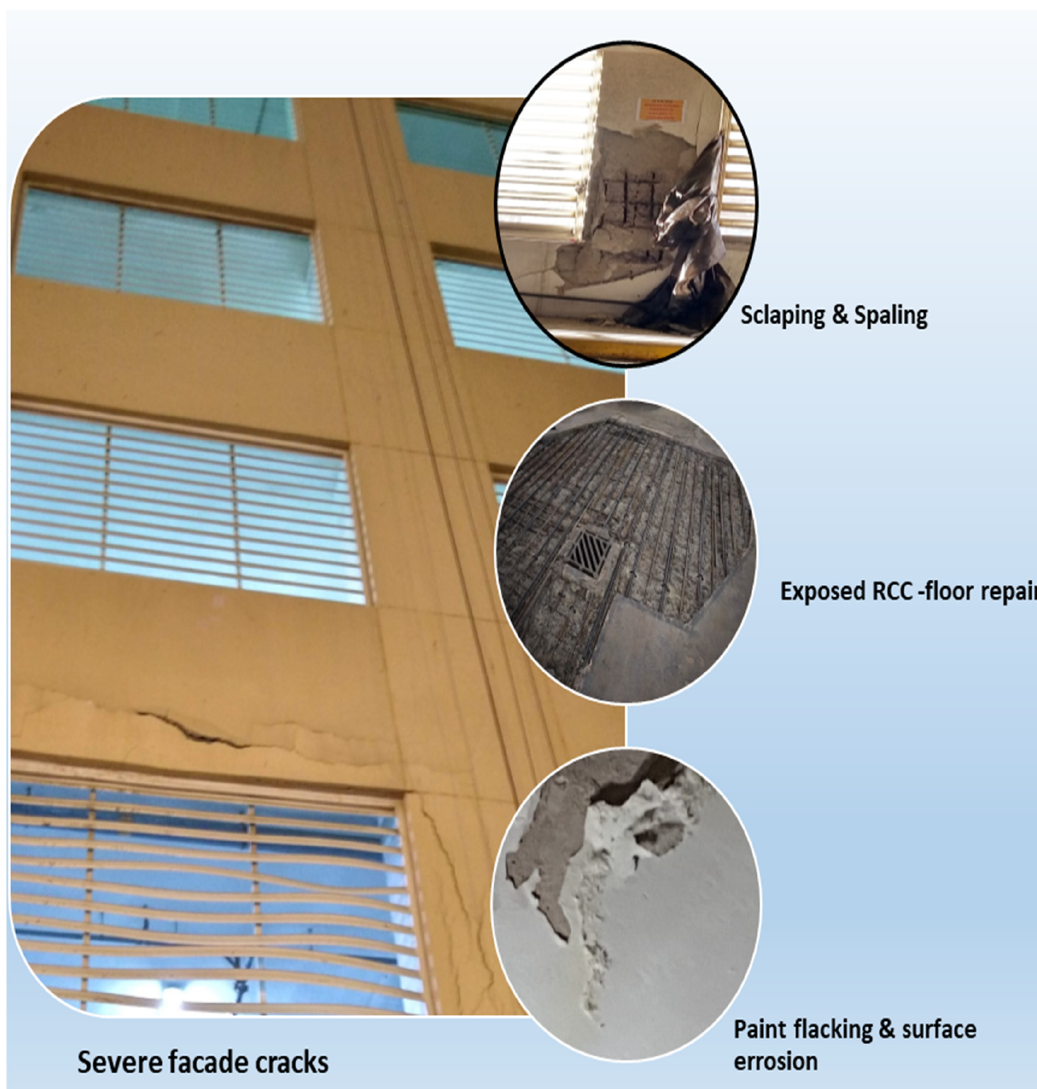
Figure 3. Construction and structural defects.